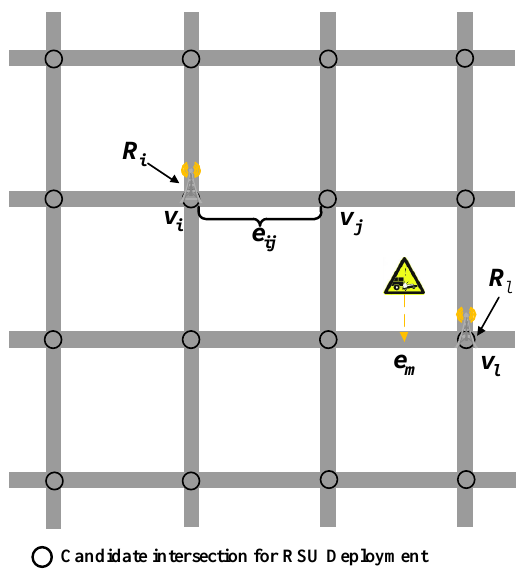
Figure 8. Grid-like urban street.